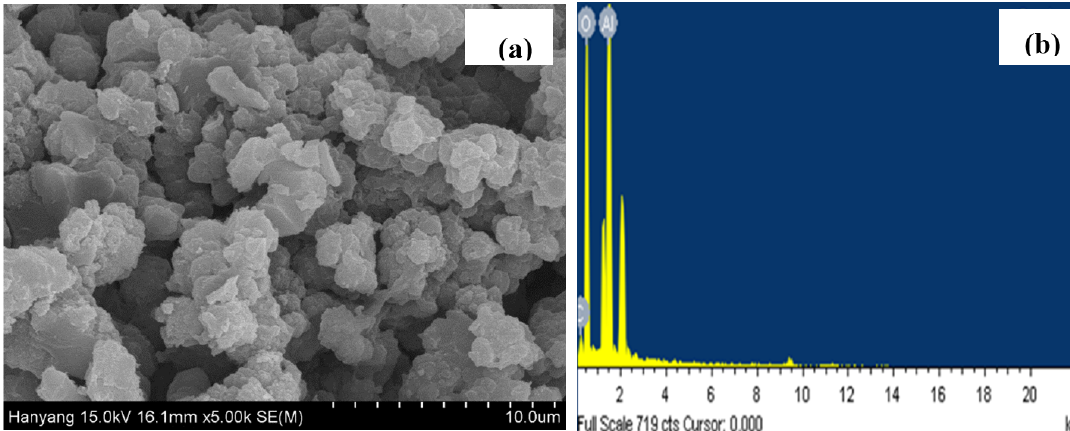
Figure 10. Morphology ( a ) SEM image and ( b ) EDS of passive film formed on the Al coating surface after 384 h of exposure in SAE J2334 solution.